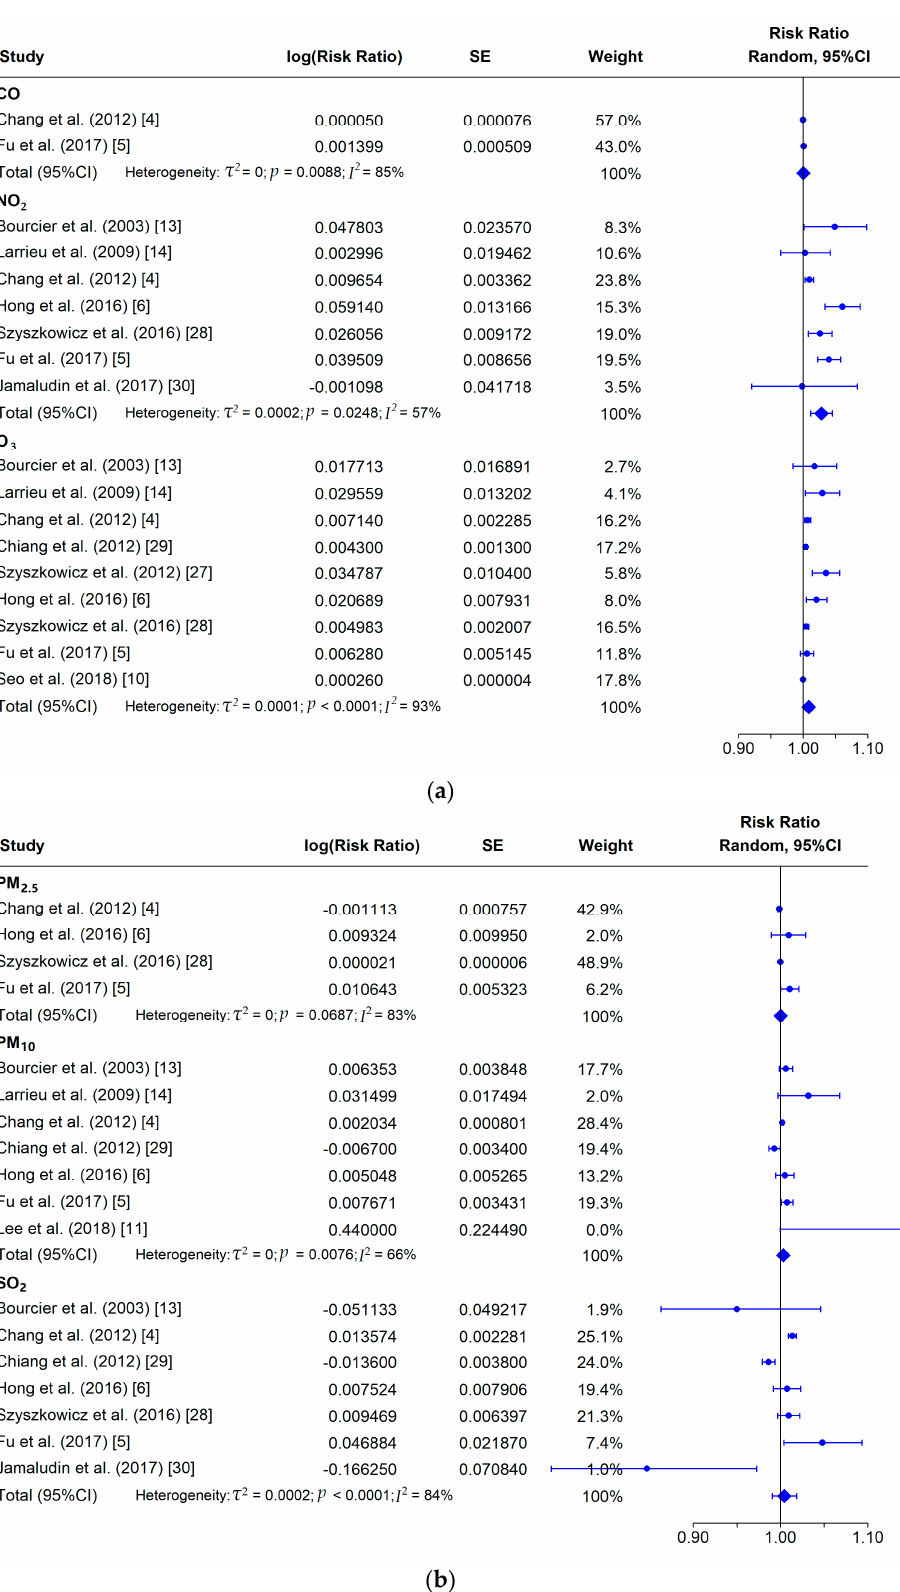
Figure 2. Forest plot of the association between conjunctivitis and exposure to air pollution: ( a ) CO, NO 2 , O 3 ; and ( b ) PM 2.5 , PM 10 , SO 2 . Risk ratio was calculated by considering a 10 μ g/m 3 increase of air pollution.